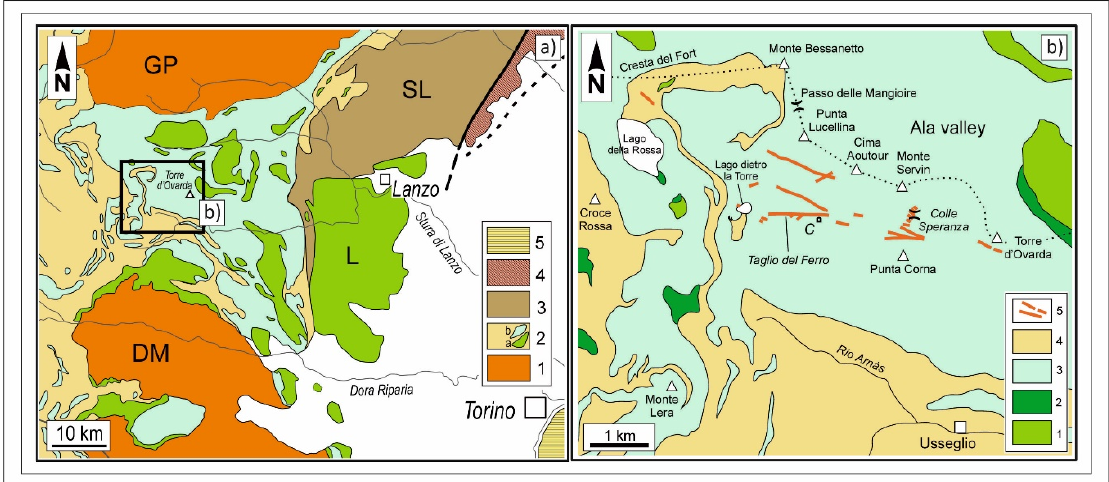
Figure 8. ( a ) Simplified tectonic sketch-map of the central sector of the Western Alps. 1: internal crystalline Massifs of Gran Paradiso (GP) and Dora Maira (DM); 2: Piemonte Zone (a: main ultramafic